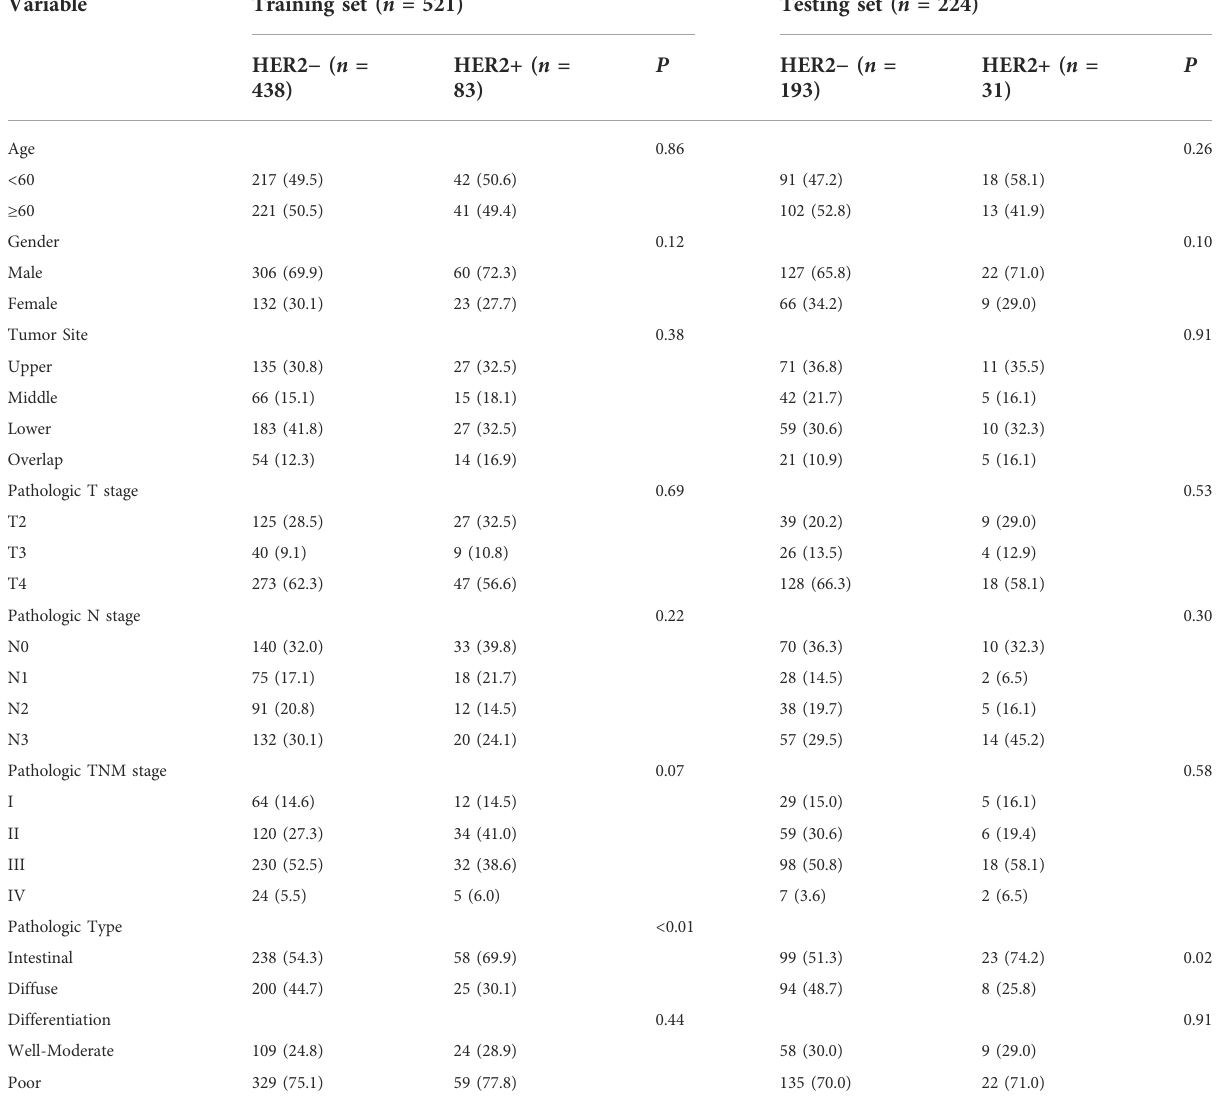
TABLE 1 Characteristics of the study